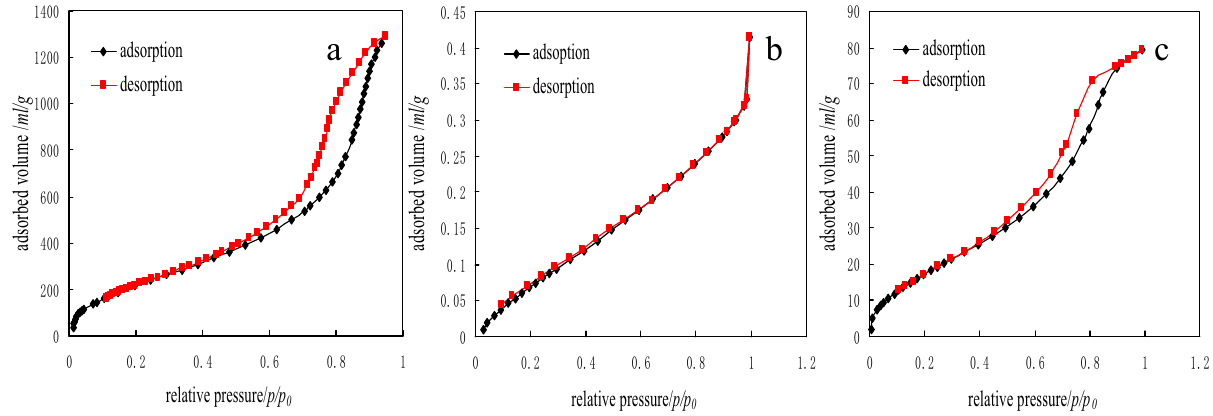
Figure 3: N 2 adsorption – desorption isotherm (( a ) SiO 2 ( AG ) , ( b ) T - ZnO, and ( c ) SiO 2 ( AG ) /T - ZnO ) .